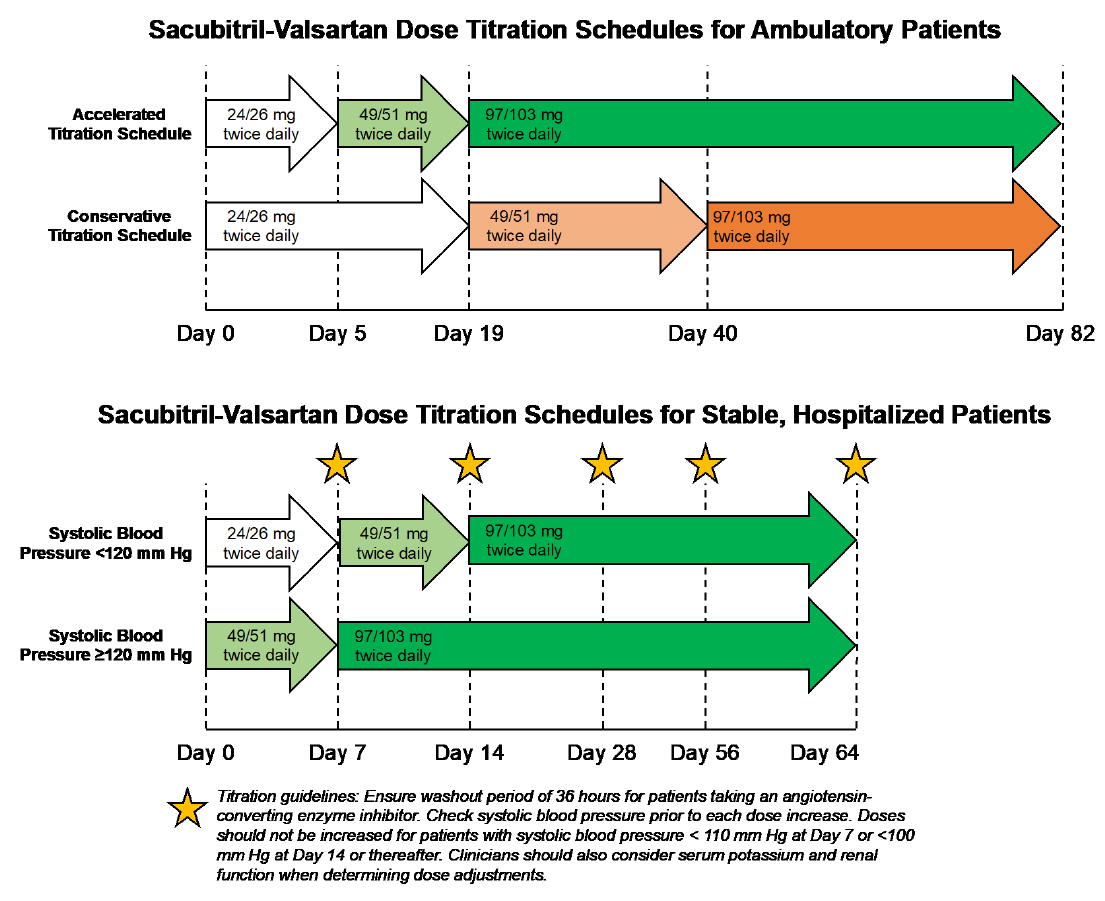
Figure 1. Titration schedules for ambulatory and hospitalized patients initiating